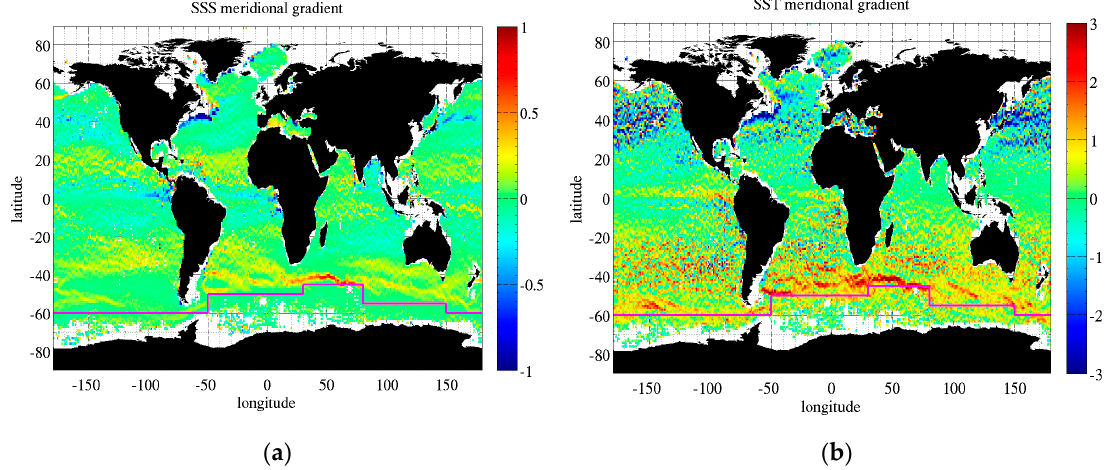
Figure 10. Maps of meridional gradients of ( a ) SSS in psu per degree of latitude and ( b ) SST in °C per degree of latitude computed from monthly Argo maps. The magenta line reports the approximate location of the Antarctic Convergence.